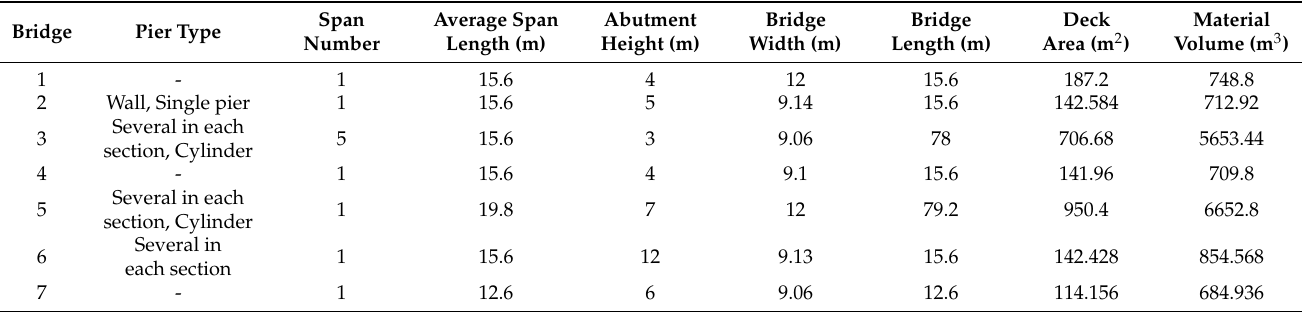
Table 1. Approximate volume of elements for risk